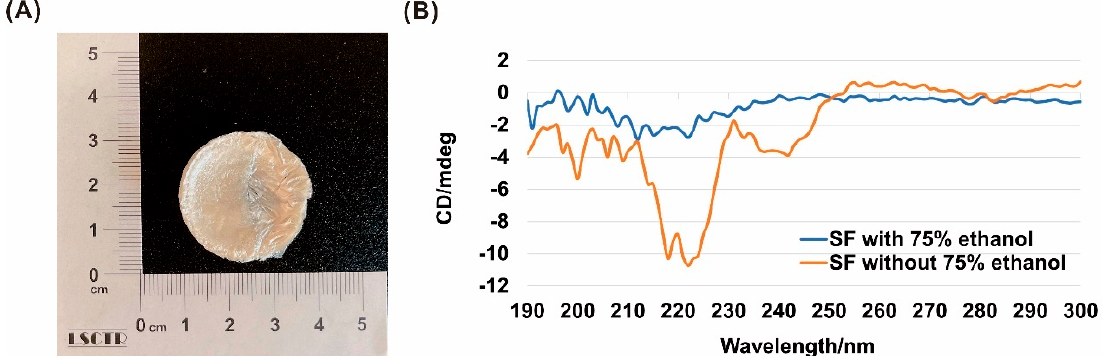
Figure 1. ( A ) Lyophilized silk fibroin dressing (LSFD) for the in vivo study; ( B ) circular dichroism (CD) spectra of SF treated with or without 75% ethanol.